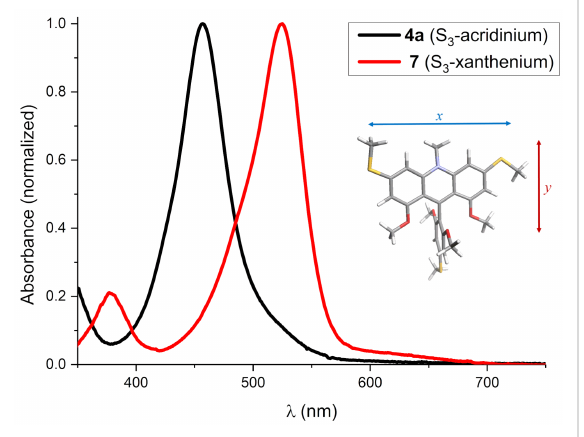
Figure 4: UV–vis spectra in MeCN: S 3 -acridinium ( 4a , black) and S 3 -xanthenium ( 7 , red). Inset: The 3D structure of 4a with indication of the principle axes of the electronic transitions.